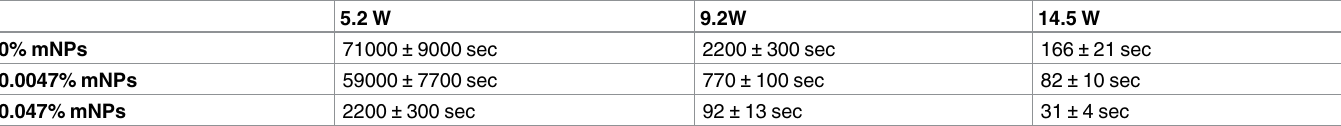
Table 3. The estimated sonication time required to obtain a lesion volume of 21 mm 3 (r = 1 mm and z = 5mm) for phantoms with three different mNP concentrations (0%, 0.0047%, and 0.047%), for acoustic powers of 5.2 W, 9.2 W, and 14.5